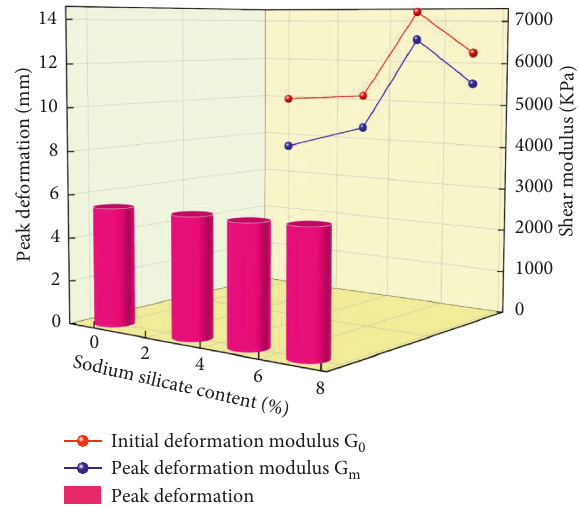
Figure 10: The effect of sodium silicate content on the shear deformation modulus and peak deformation of lunar soil simulant.